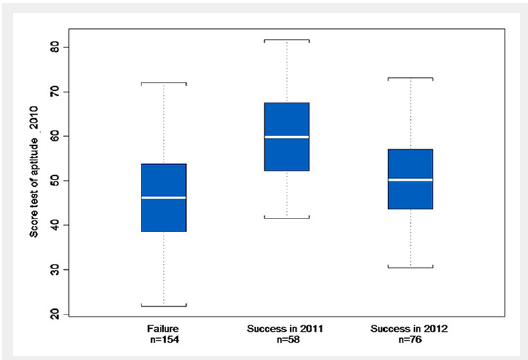
Boxplot of the scores obtained in the aptitude test in 2010 for the students who failed to pass in bachelor year 2 within the time allowed (two academic years), the ones who succeeded immediately (success in 2011) of after repeating year 1 (success in